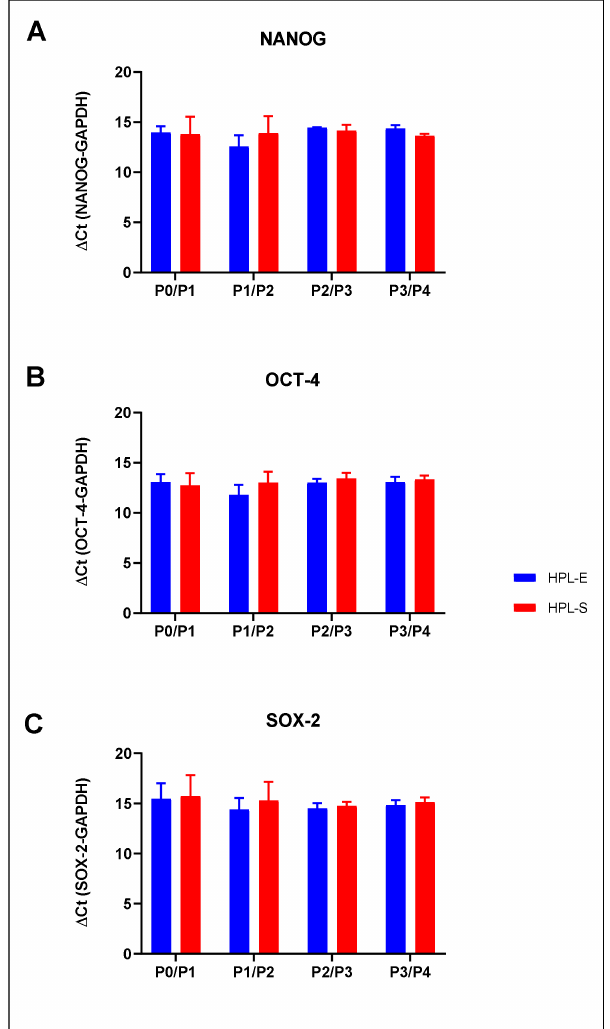
Figure 8. Stem cell markers analyses by RT-PCR: NANOG ( A ), Oct-3/4 ( B ) and Sox-2 ( C ) expression is shown as means with SEM of five experiments in HPL-E (blue columns) and HPL-S (red columns) at different passages. No significant differences were observed between the HPLs and between the